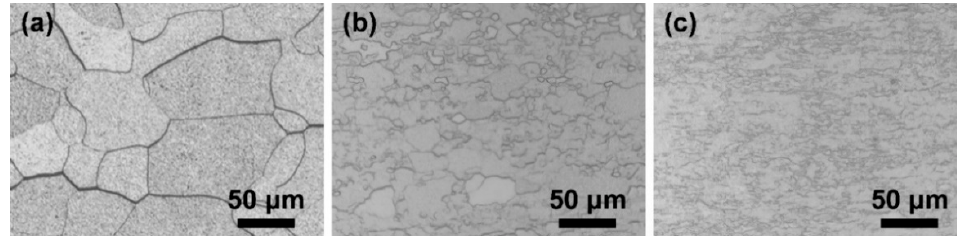
Figure 8. The metallographic structure of the W foil laminates with different diameter of ( a ) Ø13 mm; ( b ) Ø20 mm; ( c ) Ø25 mm after FAST joining at 800 °C. ( b ) Ø20 mm; ( c ) Ø25 mm after FAST joining at 800 ◦